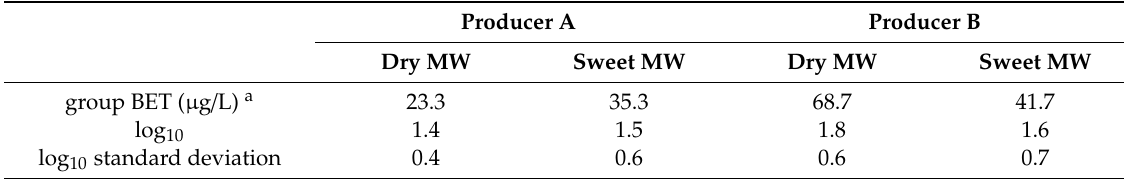
Table 3. Group best estimate odor thresholds (BETs) obtained for the orthonasal odor threshold of sotolon in 3-year-old